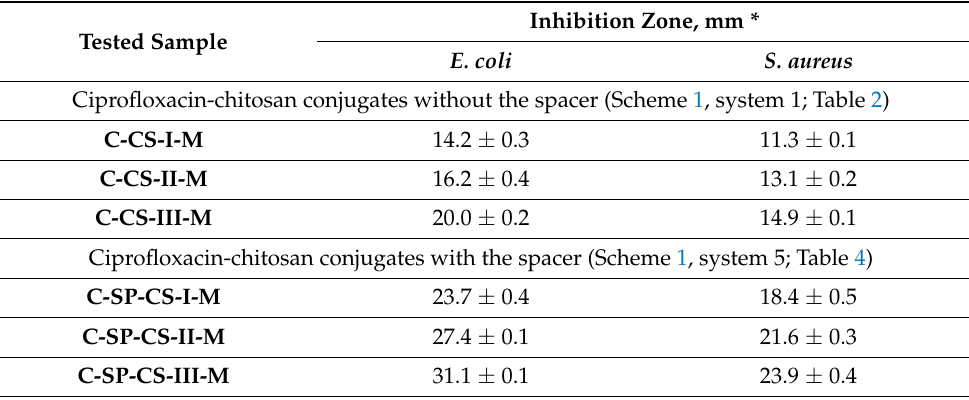
Table 9. Antibacterial activity of ciprofloxacin/chitosan-based conjugates and nanoparticles. Tested